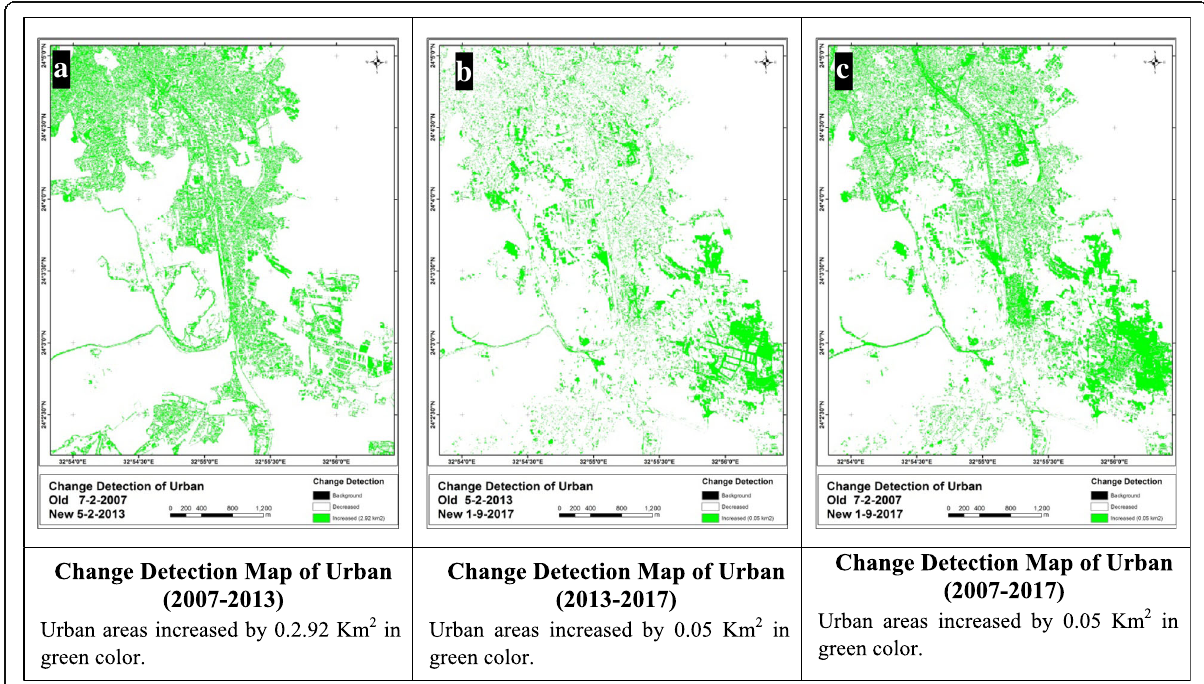
Fig. 11 Change detections in urban areas through the period 1987-2014 in the study area a Change Detection Map of Urban (2007-2013), b Change Detection Map of Urban (2013-2017) and c Change Detection Map of Urban (2007-2017)